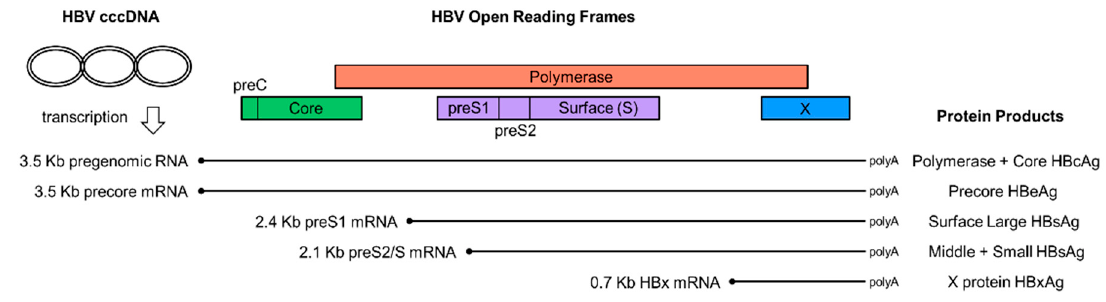
Figure 1. Hepatitis B virus (HBV) gene expression. The HBV covalently closed circular DNA (cccDNA) serves as the template for the transcription of the pregenomic RNA and subgenomic messenger RNA (mRNA) transcripts (shown as thin lines), aligned to a linear depiction of the viral open reading frames (shown as open boxes). The corresponding protein products for each of the major HBV transcript are listed on the right. HBcAg: HBV core antigen; HBeAg: HBV early antigen; HBsAg: HBV surface antigen; HBxAg: HBV X protein.